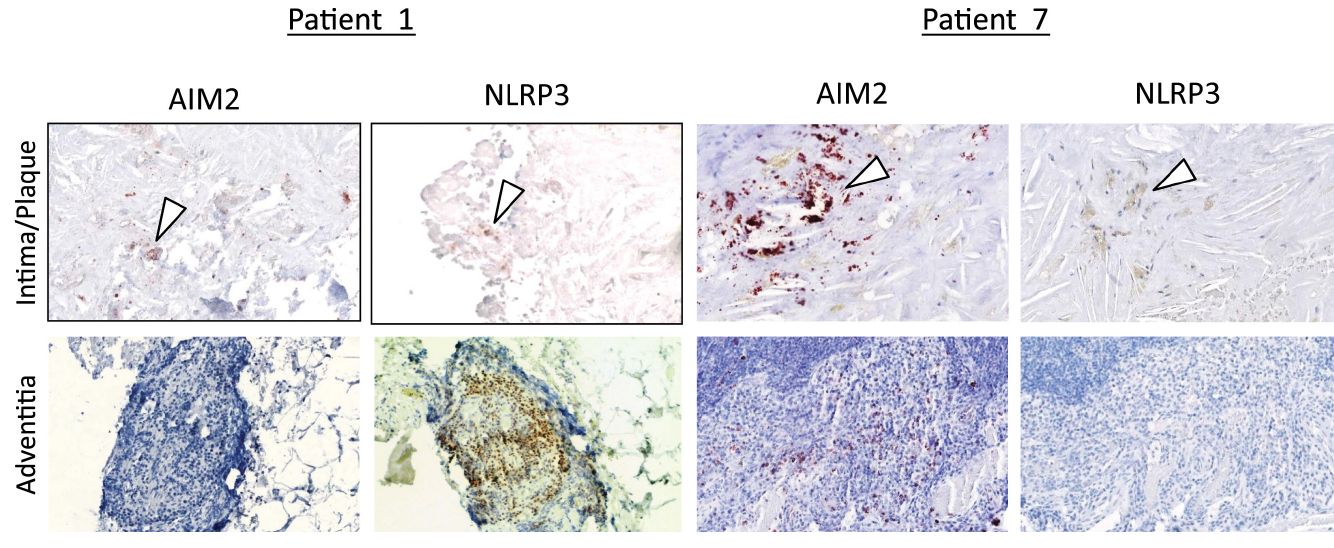
Figure 4. Immunohistochemical analysis of NLRP3 and AIM2 expression in AAA infiltrates. Examples of two AAA biopsies, corresponding to PBMC samples of the same AAA-patient are shown. Arrows point to infiltrating inflammatory/immune cells positive for AIM2 or NLRP3 proteins, respectively. Upper layer: atherosclerotic area at the luminal site. Lower layer: lymphoid infiltrates within the adventitia of the same patient. Original magnifications: